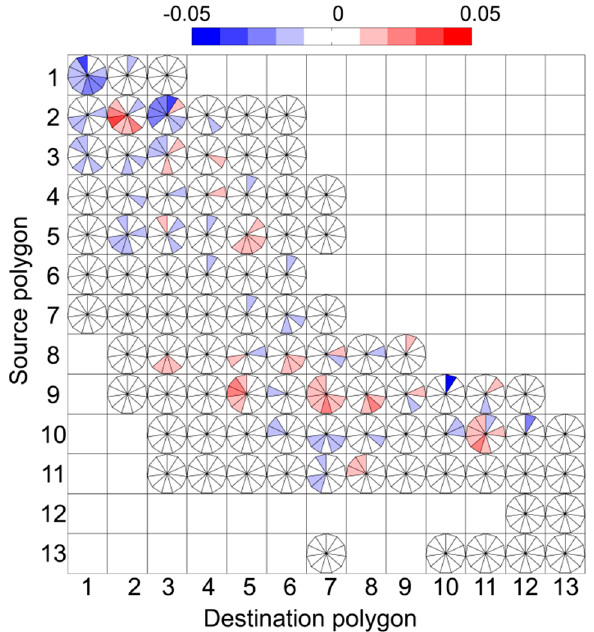
Figure 5. DRCM 5000–1000 showing the change in connectivity when 5000 particles instead of 1000 are released. Positive (red) and negative (blue) values indicate stronger and weaker connectivity differences between RCM model where n = 1000 particles subtracted from RCM model output where n = 5000 particles.